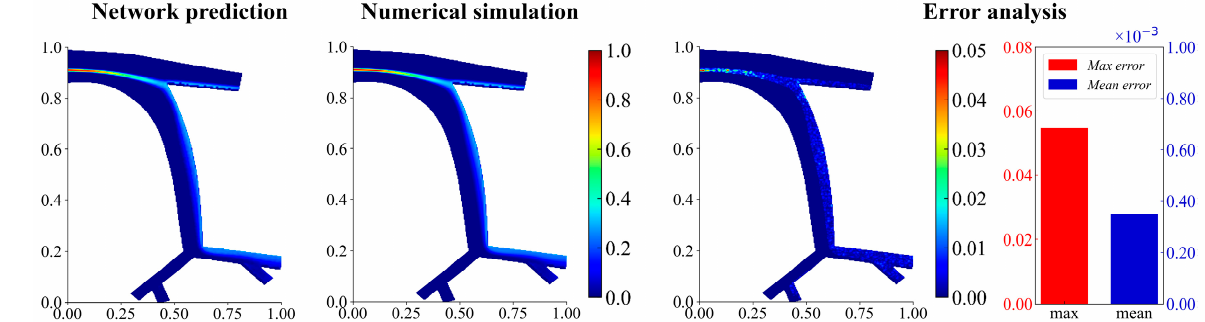
Figure 10. Drug concentration field and error distribution of the human hepatic artery trained by the network model, Model 1.